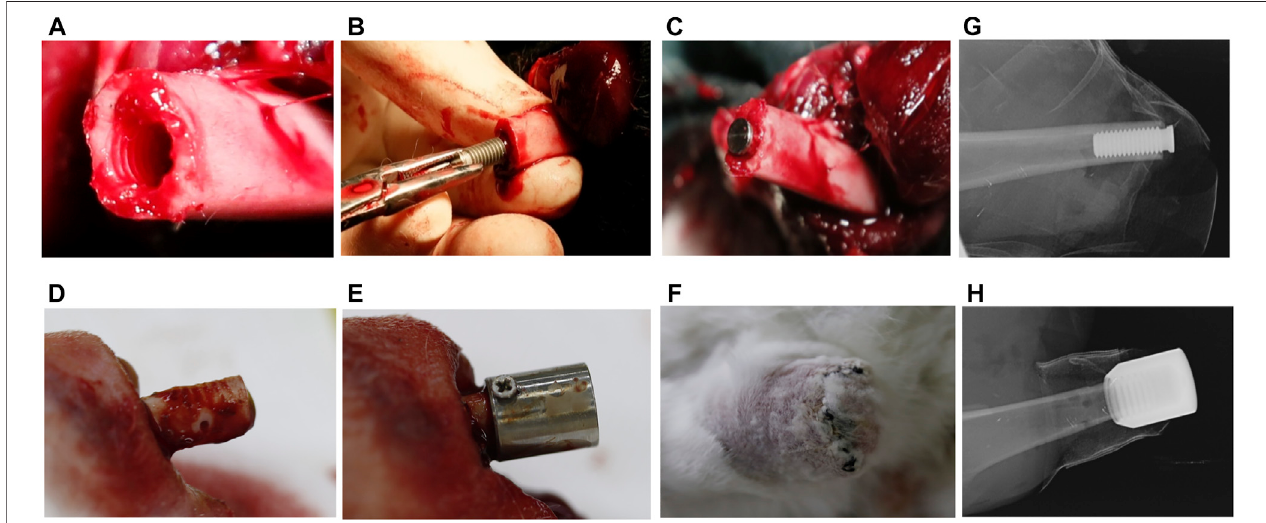
FIGURE3| ThesurgicalprocedureofimplantationinNewZealandRabbits. (A) Preparationofthetransplantbedbeforeimplantationofinternalcolumnarimplants; (B) the internal columnar implant was successfully implanted; (C) the columnar implant inside the medullary cavity; (D) preparation oftransplant bed before implantation of external cap implants, with drilling holes on the cortical bone; (E) the external cap implants outside the medullary cavity; (F) the external cap implant was successfully implanted; (G,H) X-ray examination after surgery.